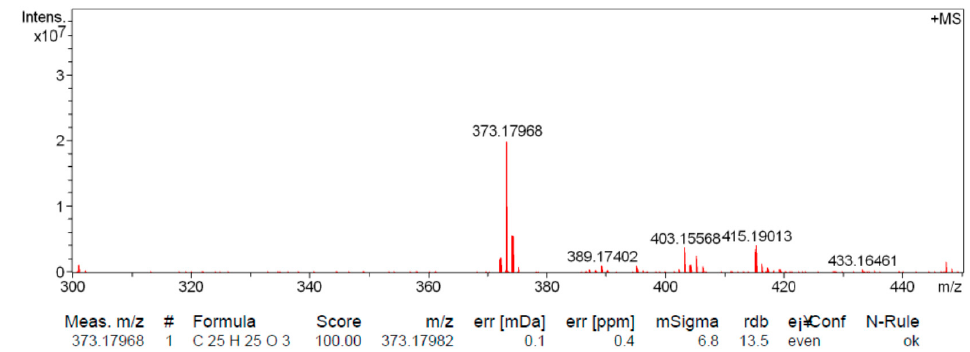
Figure 3. HR-APCI-FT-ICR-MS spectrum of AHP.